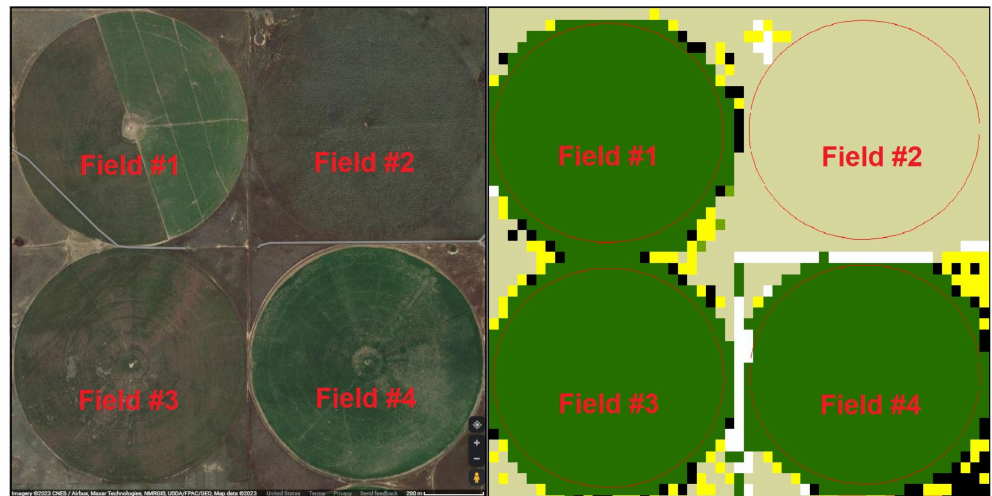
Figure 2. A standard 400 m radius irrigated field (field #2) in its transition into grassland (left panel) compared to the remotely sensed Crop Data Layer (right panel, 2019 data) of the same location. Data Source: NASS, USDA; Google Maps. Note: The remote sensing data in the right panel indicate that corn (in dark green) was grown in fields #1, #3, and #4 in 2019. Later, in 2021 (corresponding to the time of the left panel Google Maps imagery), field #3 was in idle status and fields #1 and #4 still had